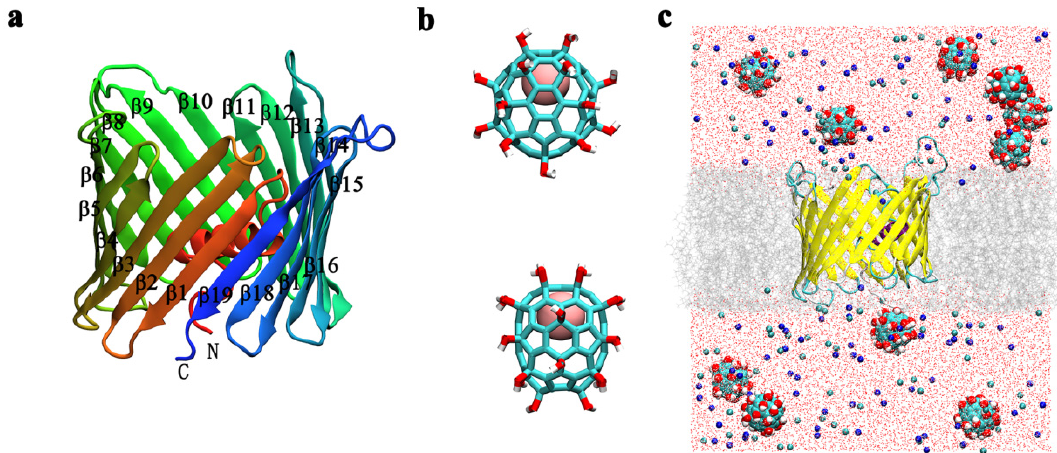
Figure 1. ( a ) The NMR solution structure of the hVDAC1 protein. The protein is illustrated with ribbon colors representing the transition from the N-terminus (red) to the C-terminus (blue). Human VDAC1 comprises a nine-residue-long N-terminal loop, an α -helix, and nineteen β -strands that form a circular bucket ( β -barrel) with the N-terminal loop and helix embedded in the hollow lumen. ( b ) The structure of the Gd@C 82 (OH) 22 molecule. The encaged Gd 3+ ion is shown as a pink sphere, and the fullerenol cage is represented as sticks. ( c ) The initial in silico system setup. The Gd@C 82 (OH) 22 molecule is shown with vdW sphere; hVDAC1 is shown with a yellow ribbon and colored according to the secondary structure elements. The protein is embedded in the lipid bilayer represented by grey lines. Blue and cyan balls represent potassium and chloride ions, respectively. The red dots are the oxygen atoms of water molecules.